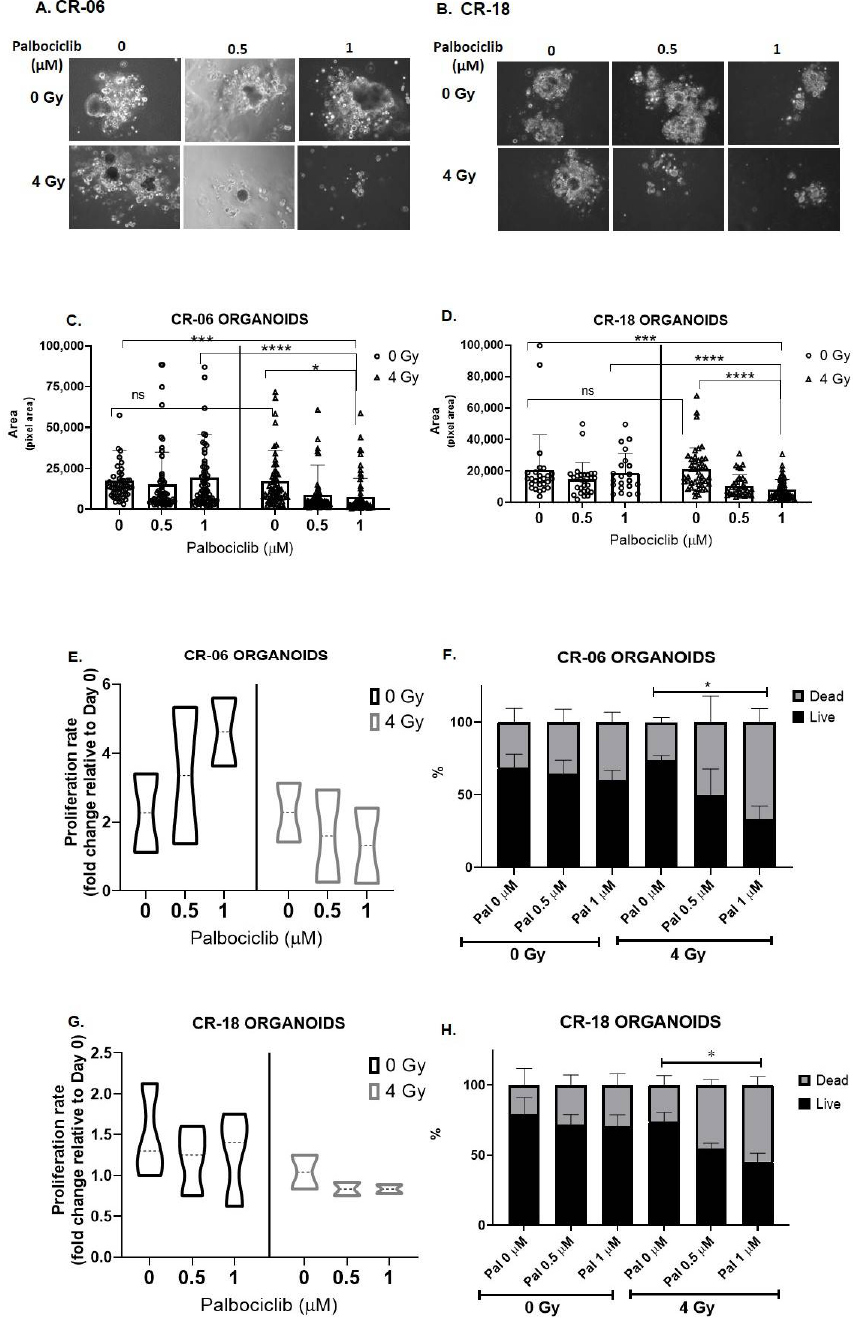
Figure 6. Palbociclib in combination with radiation reduces proliferation and potentiates cell killing in patient-derived HPV(−) OCSCC organoids. Patient-derived OCSCC CR cells grown in 3D culture for 72 h in the presence of palbociclib combined with radiation treatment exhibit reduced organoid formation, decreased organoid size, and decreased cell viability in a dose-dependent fashion in CR-06 ( A ) and CR-18 ( B ) Scale = 100 µ m. Organoid size was measured on day 12 by measuring pixel area of 50–100 random spheroids in Image J in CR-06 ( C ) and CR-18 ( D ). Cell proliferation was calculated on the basis of total number of cells on the day of termination (day 12) relative to cells seeded on day 0 in CR-06 ( E ) and CR-18 ( G ). Cell viability was evaluated by trypan blue assay on day 12 in CR-06 ( F ) and CR-18 ( H ). Analysis by one-way ANOVA. * p < 0.05; *** p < 0.005; **** p < 0.001. Each data point mean represents the average represented from three individual experiments. Pal—palbociclib;